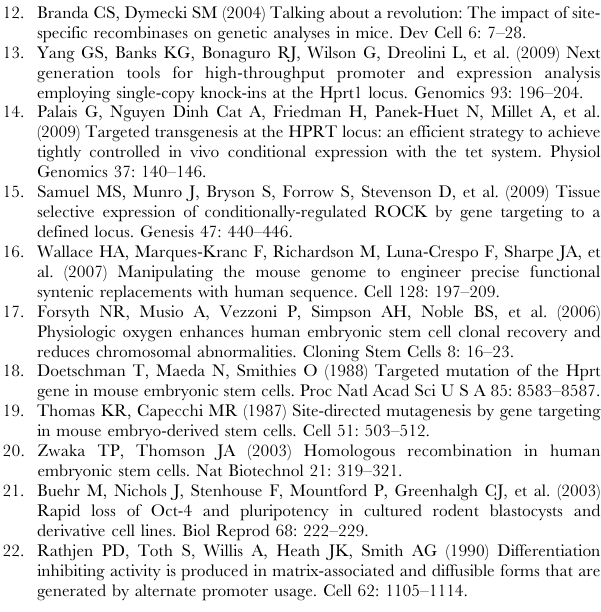
Figure S1 Effect of oxygen concentration on rat embryonic stem cell growth. (A) Brightfield images of two F344 cell lines, 23 days post-derivation, maintained in 2% or 21% oxygen (magnification x100). (B) Growth rate of six F344 lines, from inner cell mass isolation to passage four, grown in either 2% or 21% oxygen. Found at: doi:10.1371/journal.pone.0014225.s001 (0.47 MB Figure S2 Targeting of the HPRT gene in Sprague Dawley rat embryonic stem cells with a PGK/neo targeting vector. (A) Targeting diagram as described in Figure 1A, except that an frt flanked PGK/neo cassette was used to replace exons 7 and 8. (B) Confirmation of targeted integration by Southern blot analysis of XbaI digested genomic DNA from (1) RISD10 parental cell line, (2) RISD10-derived 6-TG-resistant clone 2.2.14 using 5 9 probe shown in (A). (C) Brightfield image of RISD10 targeted cell line 2.2.14 (Magnification x100). Figure S3 Characterisation of HPRT targeted Sprague Dawley rat embryonic stem cells. (A) Immunohistochemical staining of targeted clones 2.2.14 and 6.7.16 for Oct4 and Nanog (Magnification x100). (B) RT-PCR analysis of (1) Water blank, (2) DIA-M feeder layer, (3) rat E10.5 embryo, (4) rat ES cell